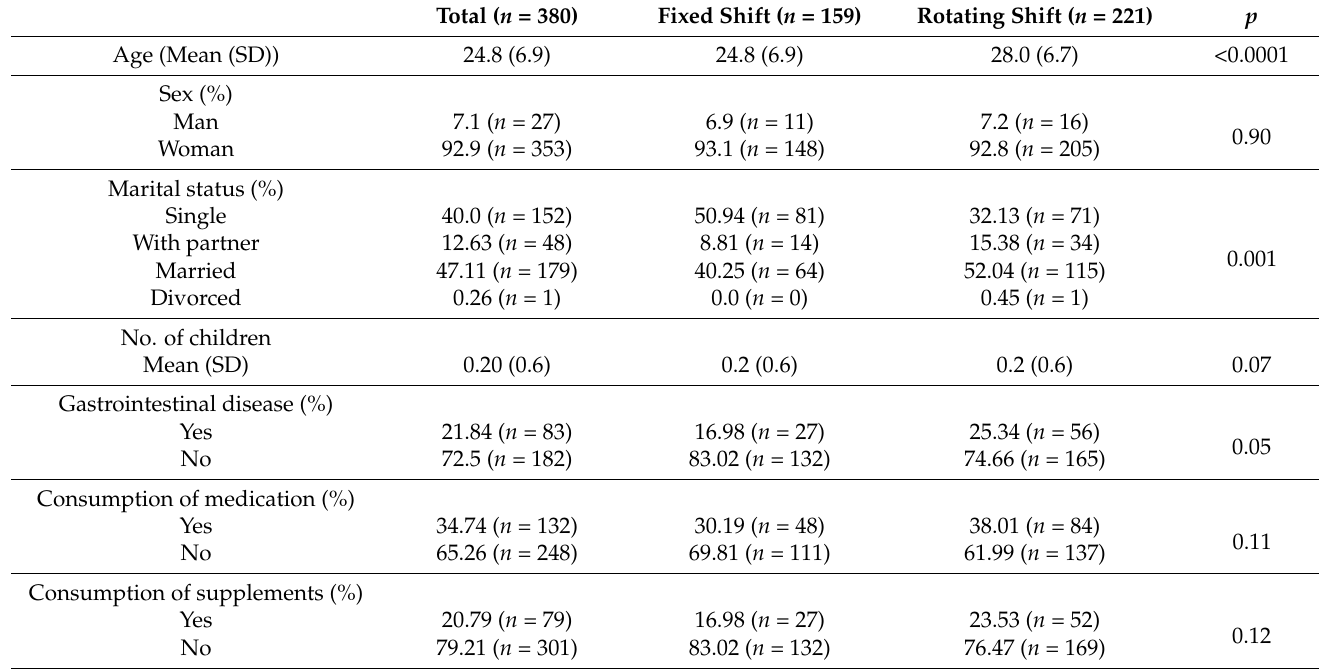
Table 2. Sociodemographic characteristics of participants according to work